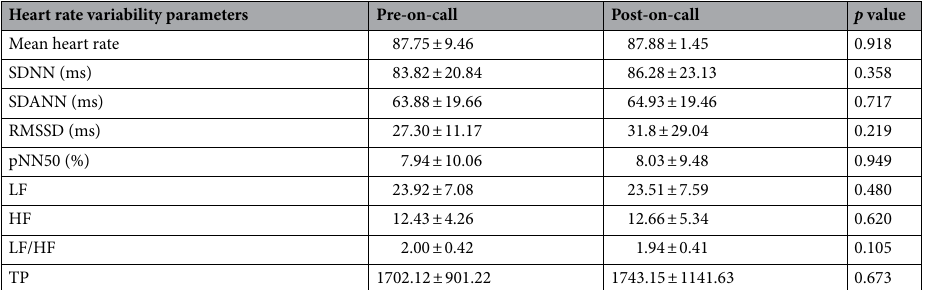
Table 2. Heart rate variability parameters during 8-h pre-call and post-call. HF high frequency; LF low frequency; LF/HF low frequency/high frequency ratio; pNN50 percentage of successive RR intervals that differ by more than 50 ms; RMSSD root mean square of successive RR interval differences; SDNN standard deviation of NN intervals; SDANN-SD of the average NN intervals; TP total power (sum of very low frequency, LF, and HF power) (ms 2